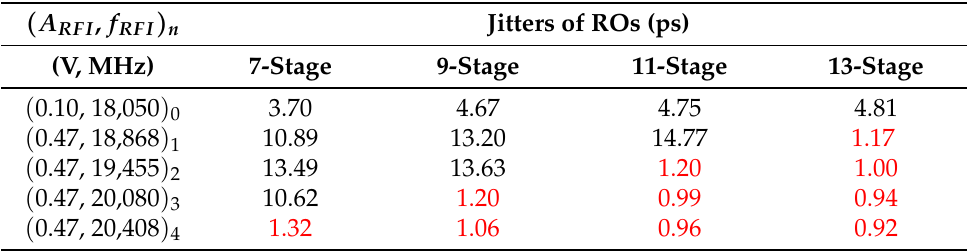
Figure 11. Experiment results of Case 1: changing inverter case. ( a ) Locking cones of ROs with different inverter sizes; ( b1 – b5 ) bitstream maps with different types of ROs locked. For Case 2, each inverter of the 7-, 9-, 11-, and 13-stage RO was loaded with 0, 0.13, 0.28, and 0.44 fF capacitors, respectively. The simulation results are shown in Figure 12, which were very similar to those of Case 1. Detailed jitter and interference information is shown in Table 5. Adding different capacitor loads can also stagger the locking regions of the ROs to improve electromagnetic immunity. Table 5. Case 1: capacitor